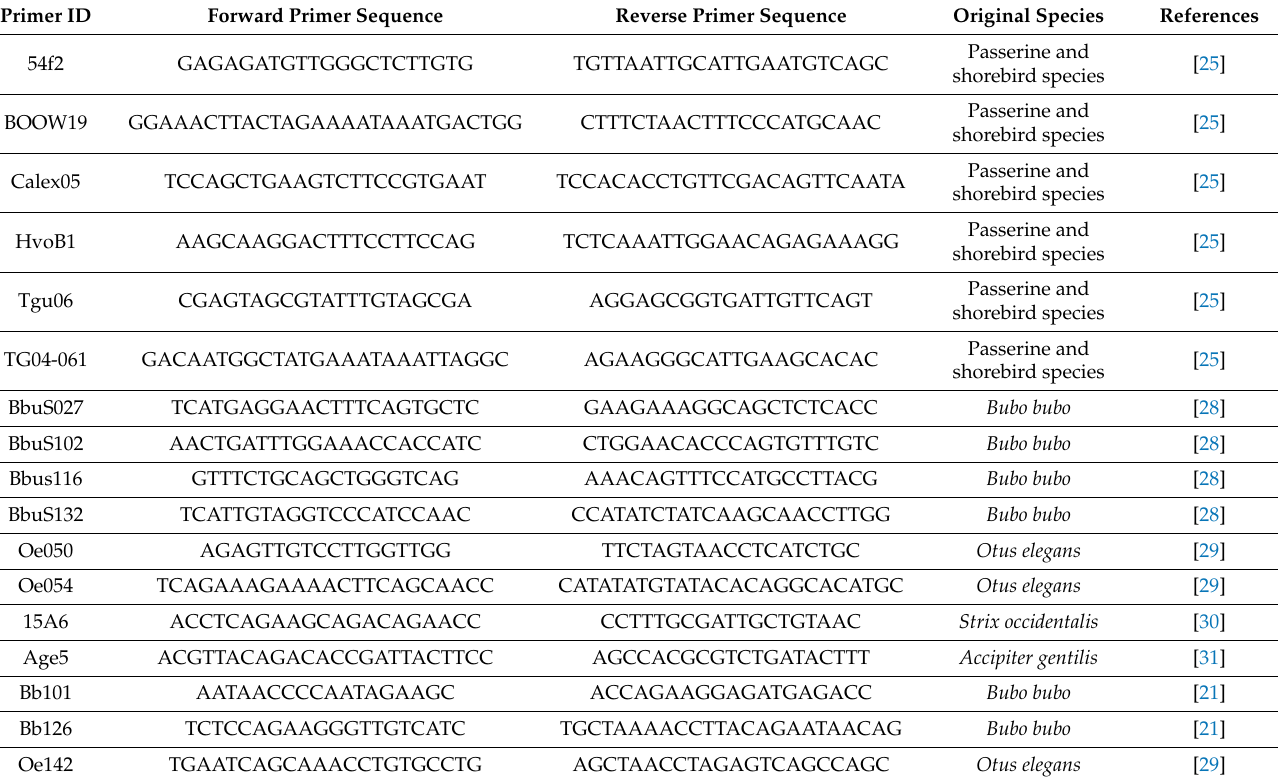
Table 2. Loci chosen from literature and tested for the cross-species amplification study. Primer ID Forward Primer Sequence Reverse Primer